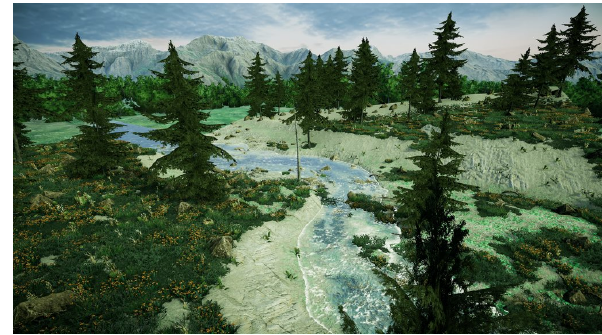
Figure 4. Screenshot from Flash Flood!